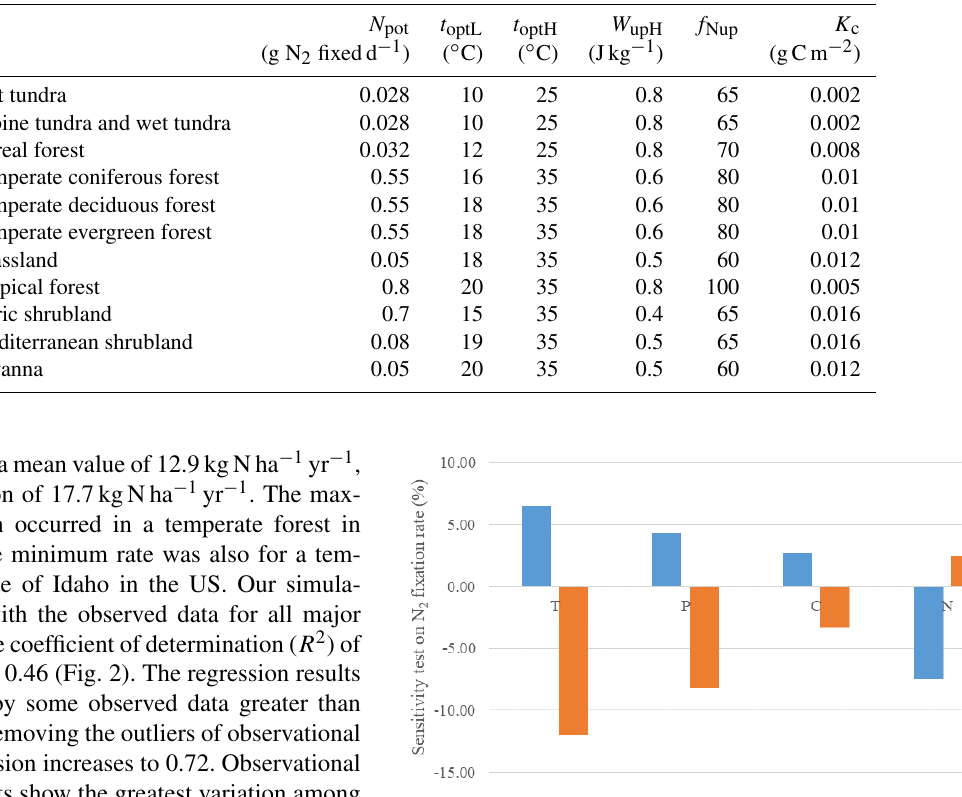
Table 4. Model parameters for various natural terrestrial ecosystems.